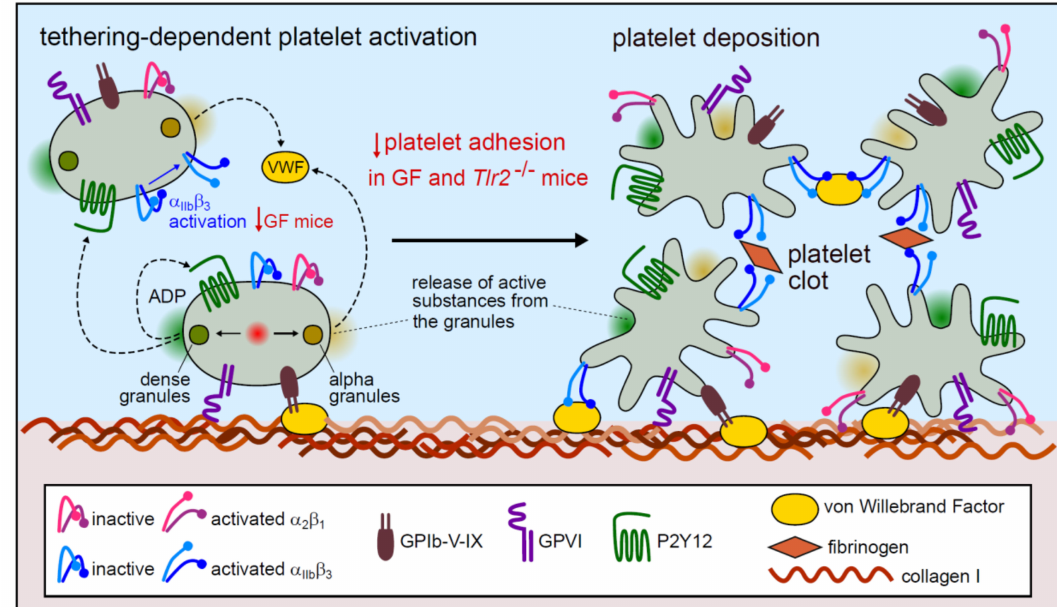
Figure 3. Model of the microbiota-modulation of static platelet deposition to type I collagen matrix. Primary platelet tethering to collagen is mediated by the GPIb-V-IX complex and the platelet GPVI receptor (purple). Subsequent platelet activation leads to α and dense granule secretion, the latter coupled with ADP release, resulting in integrin activation and firm platelet adhesion to collagen through the α 2 β 1 integrin (pink) and to binding of VWF via the integrin α IIb β 3 (blue). The integrin α β IIb 3 also contributes to platelet aggregation by the formation of fibrinogen bridges, in both the inactive and the activated